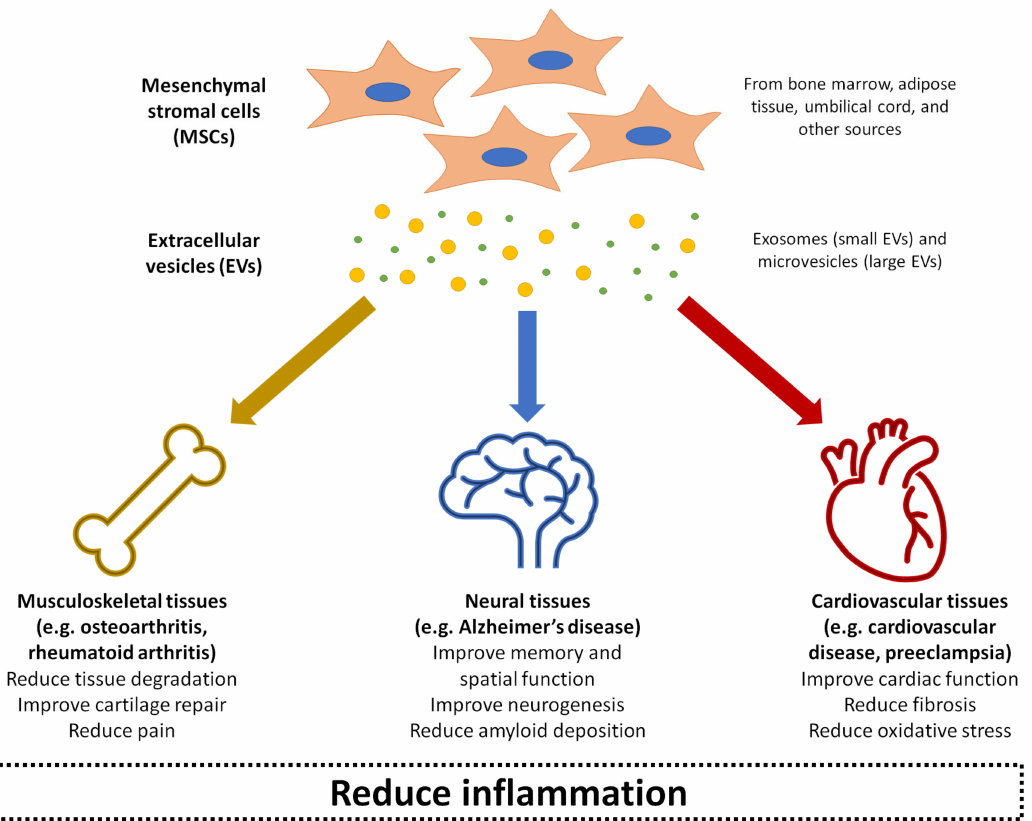
Figure 2. Summary of the application of mesenchymal stromal cell (MSC)-derived EVs in treating inflammation-related conditions as covered in this review: osteoarthritis, rheumatoid arthritis, Alzheimer’s disease, cardiovascular disease, and